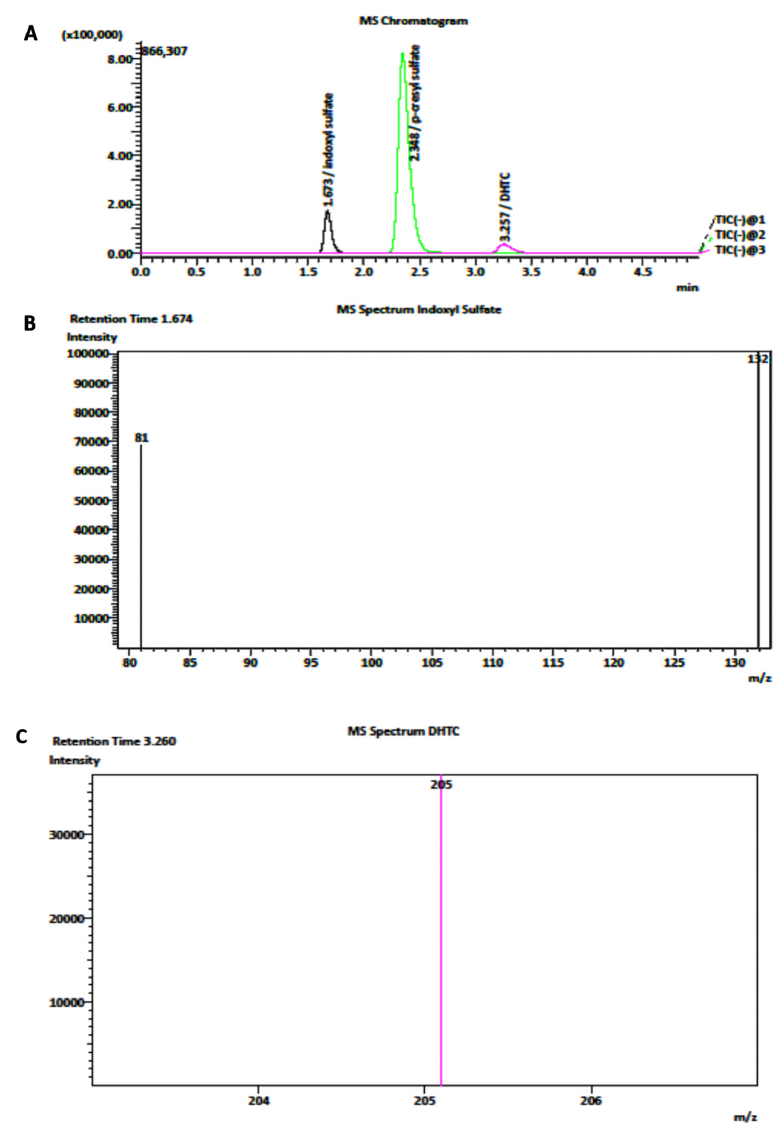
Figure 5. ( A ) Representative chromatograms of IS, DHTC, and pCS in the MRM mode with negative- mode ionization. ( B , C ) Monitored fragmentation of respectively IS and DHTC, respectively.